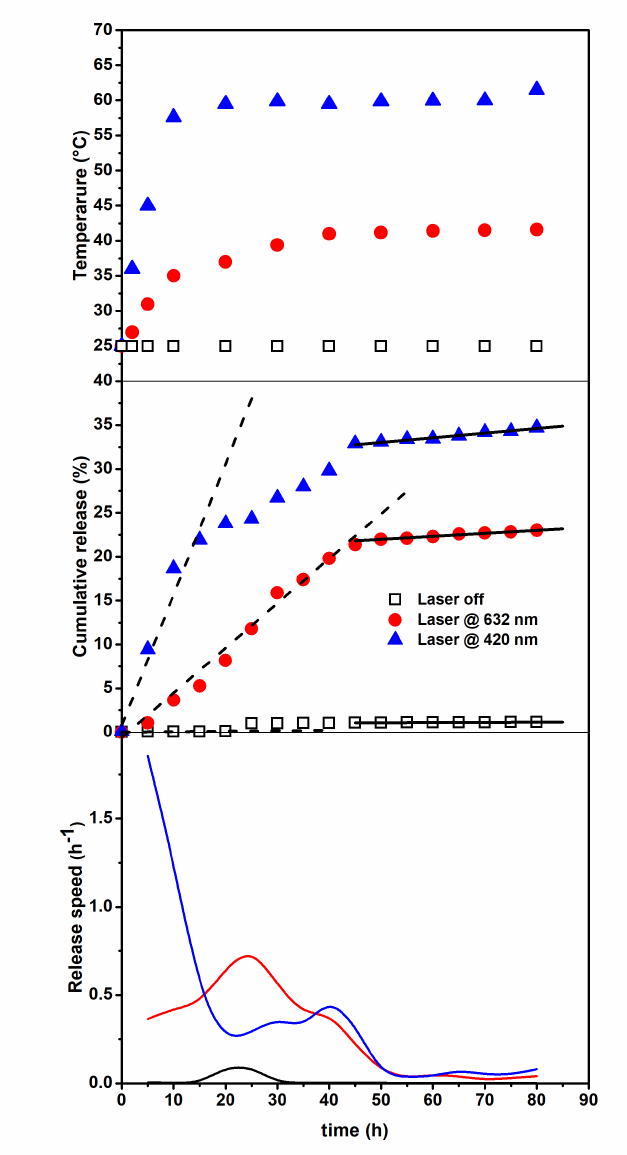
Figure 6. Temperature changes vs. time (upper panel). Cumulative release (central panel) from the SFT-Ag-PMA capsules under the 632 (circles) and 420 nm (triangles) light and with no light exposure (squares). Dashed and solid lines represent linear fits of the data in limited time intervals (see text). Release speed (bottom panel) obtained by the derivatives of the experimental